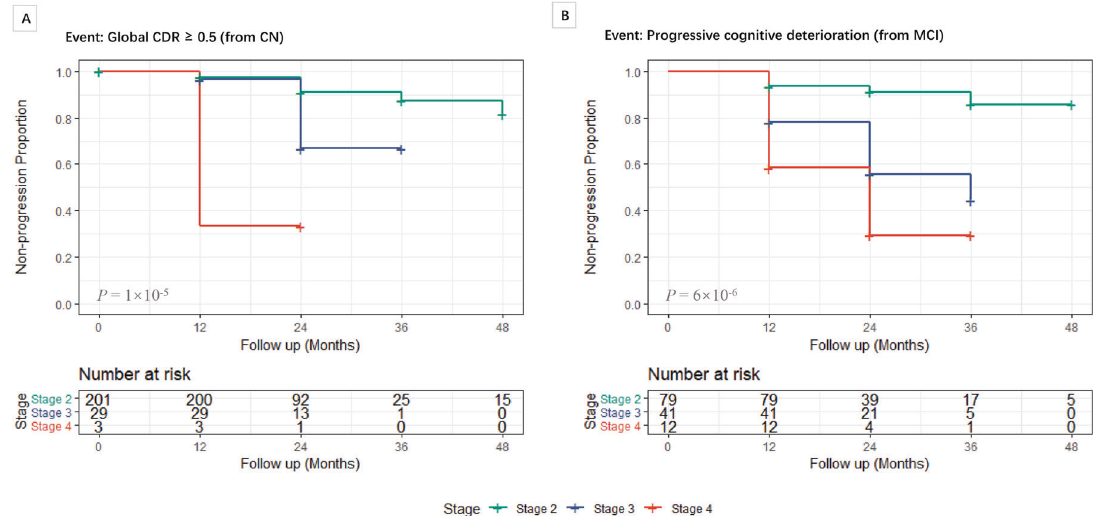
Fig. 6 Kaplan – Meier curves showing the cumulative probability of clinical progression. Clinical progression was shown for each tau stage in CN ( A ) and MCI ( B) group. Progressive cognitive deterioration de fi ned as (1) diagnosis of dementia or (2) MMSE ≤ 24 at last visit or (3) difference of MMSE ≥ 4 between the fi rst visit and the last visit. Results of the log-rank test showed a signi fi cant difference between stages. Stage 0 and stage 1 were not included in analyses for no events occurred in follow-up. CN cognitively normal, MCI mild cognitive impairment, CDR clinical dementia rating.